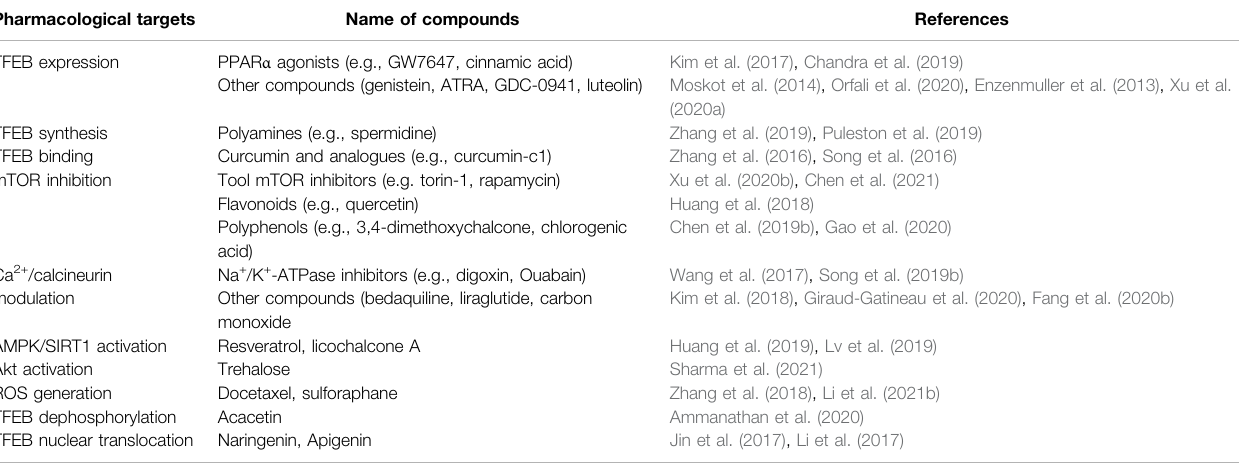
TABLE 1 | Small-molecular TFEB activators and their pharmacological